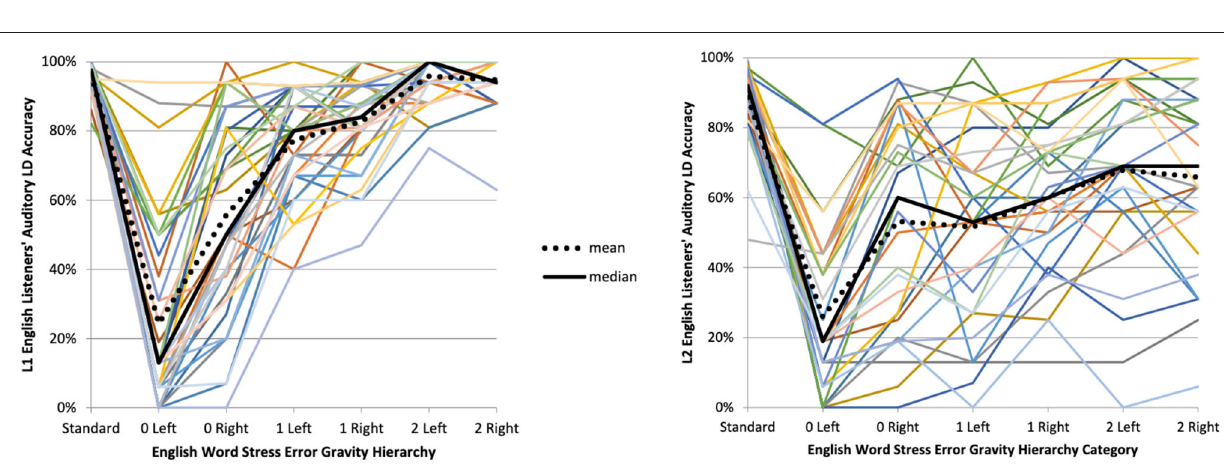
FIGURE 4 | Auditory lexical decision (LD) accuracy by English Word Stress Error Gravity Hierarchy category for L1 ( n = 38, left) and L2 ( n = 31, right) English